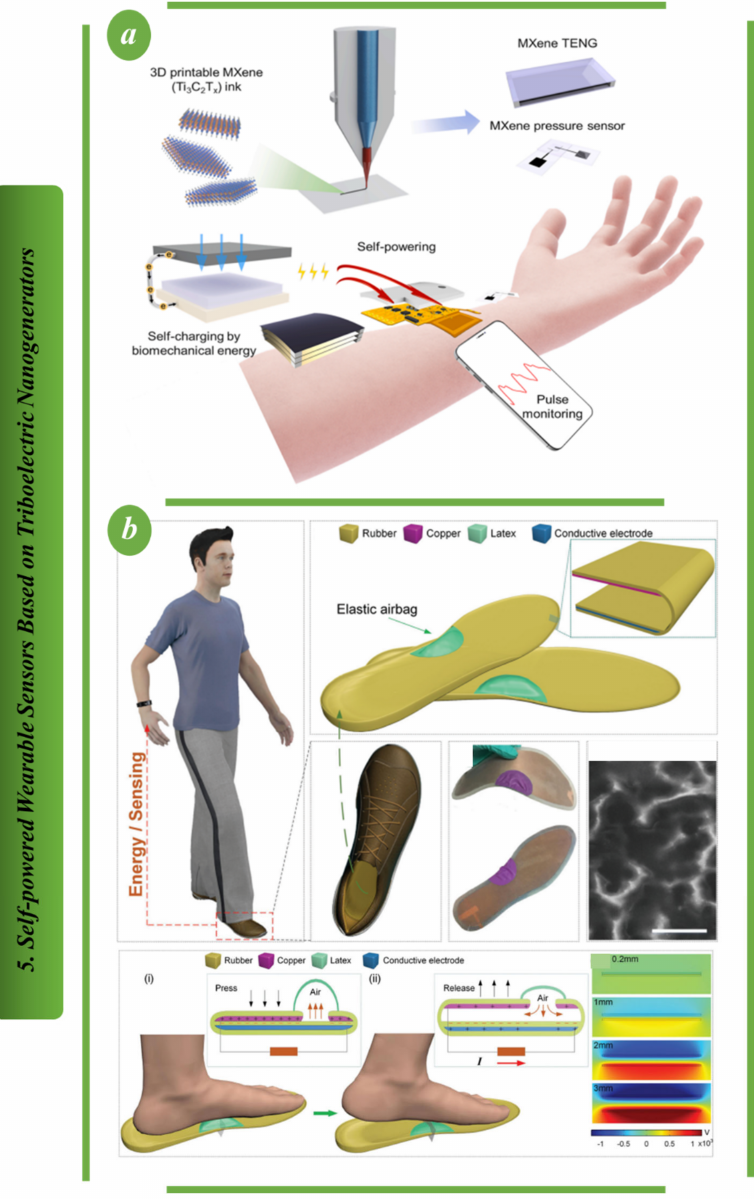
Figure 5. Self − powered wearable sensors based on TENG: ( a ) the design principal of MXene − based TENG (M − TENG) [89]. ( b ) Structural design of the TENG-based system for gathering biomedical energy